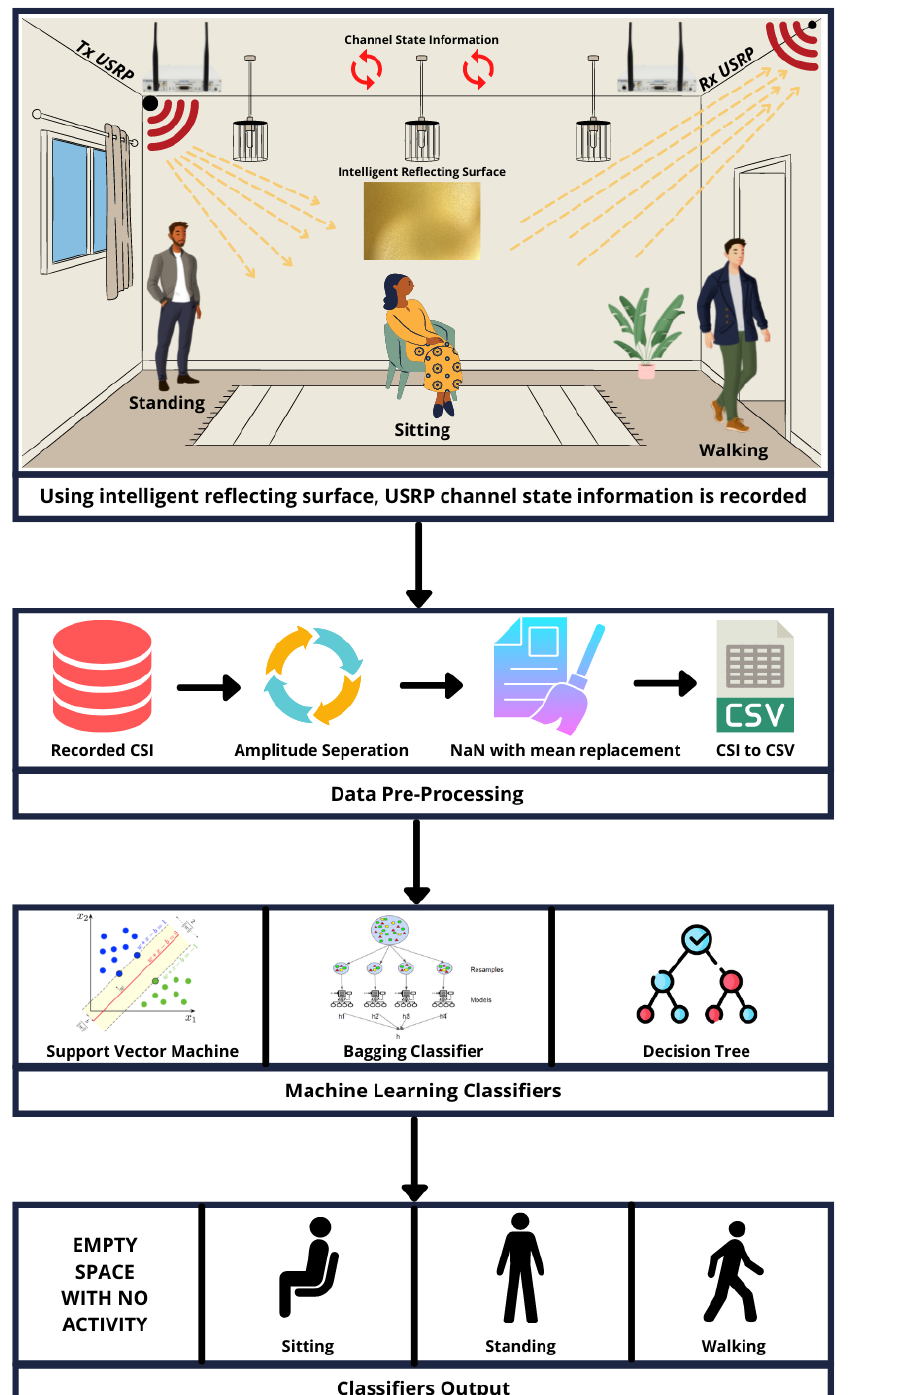
Figure 1. Block diagram of IRS-enabled system for distinct human activity